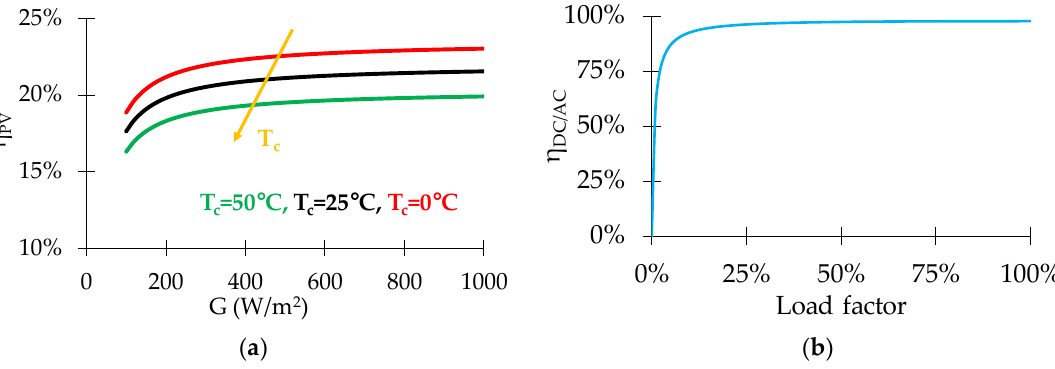
Figure 4. PV efficiency as function of irradiance and temperature ( a ) and DC/AC conversion efficiency ( b ).